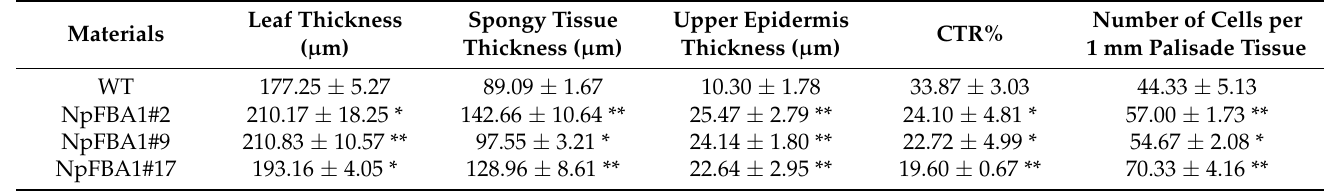
Figure 6. Comparison of anatomical structure of leaf tips of NpFBA1 -overexpressing and WT plants. Table 2. Comparison of anatomical structure indexes of NpFBA1 -overexpressing and WT